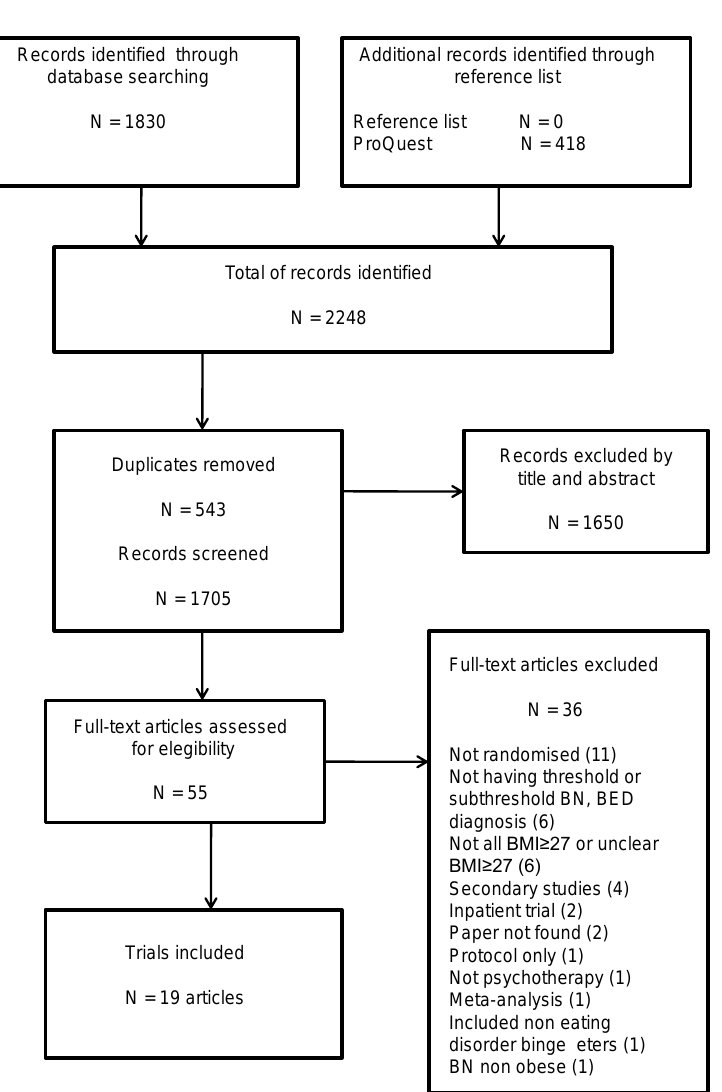
Figure 1. Prisma flow chart of study inclusion.